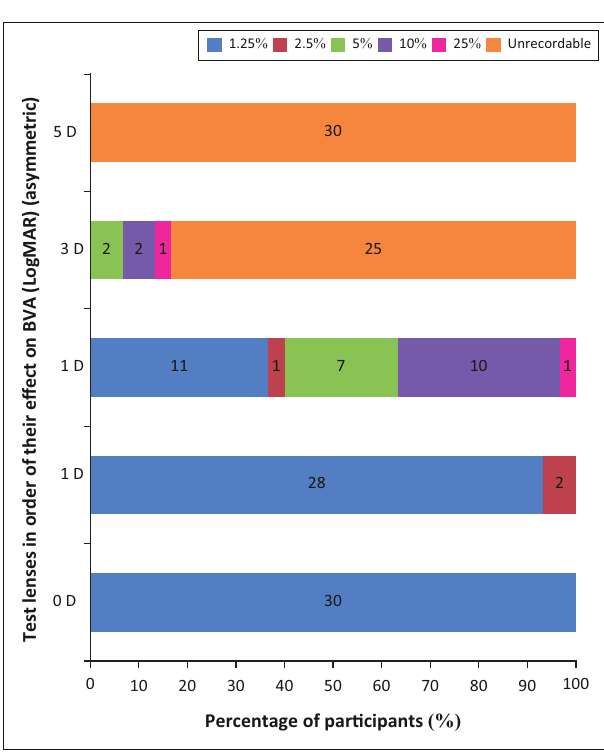
(asymmetric)3 Test lenses in order of their effect on BVA (LogMAR) BVA, binocular visual acuity; D, dioptre. FIGURE 2: Frequency of the different contrast levels with the five test lenses FIGURE 1: Mean habitual distance stereoacuity and induced stereoacuity with used to induce optical the five test lenses used to induce optical defocus.